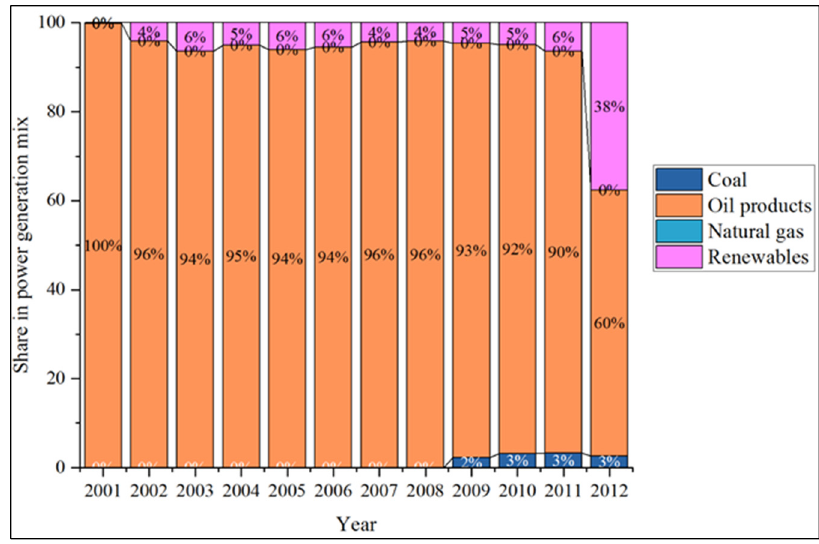
Figure 12. Cambodia: power generation